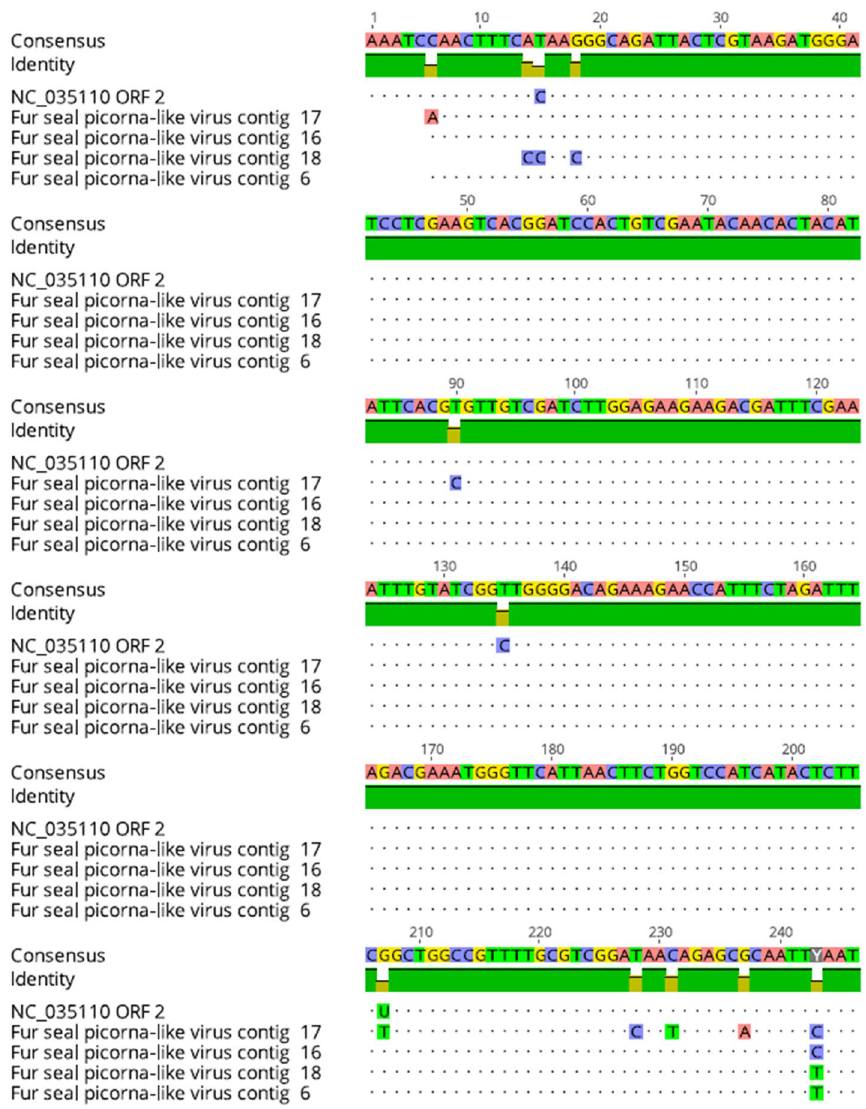
Figure 2. Nucleotide alignment of ORF2 sequences from the A. gazella picorna-like contigs compared to the ORF2 from RefSeq NC_0351110. In consensus strain, position 1 represents position 6523 from RefSeqs